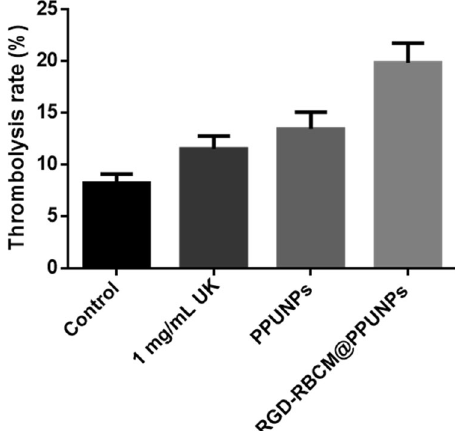
Fig. 9 Statistical chart of in vitro thrombolysis rates of PBS, UK, PPUNPs and RGD-RBCM@PPUNPs ( n = 3) Table 2 In vitro thrombolysis rate ( n = 3)